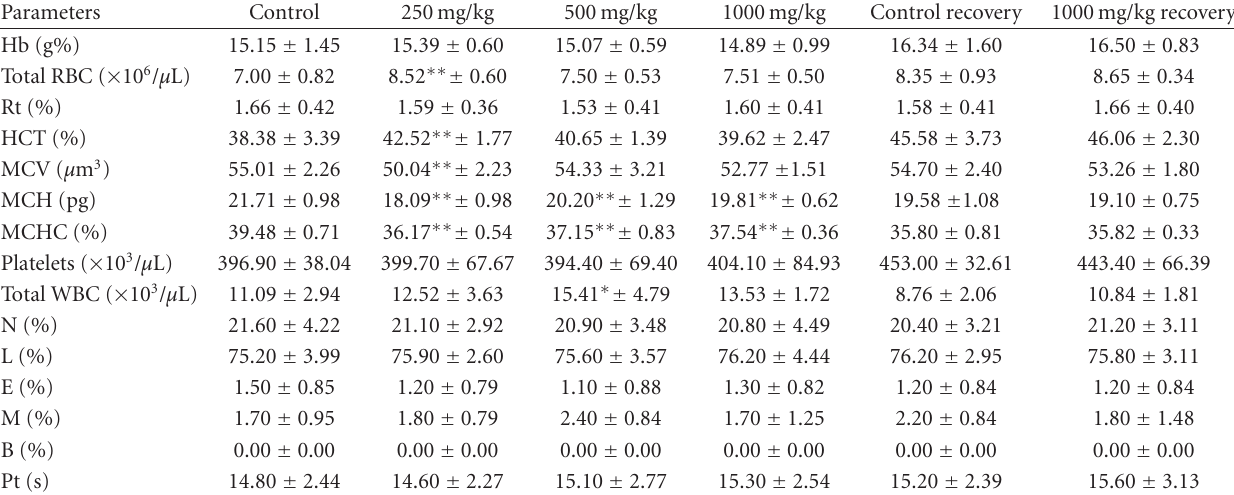
Table 2: Haematological findings (mean ± SD) in male rats after 90 days subchronic oral administration of Zigbir (cid:2) .